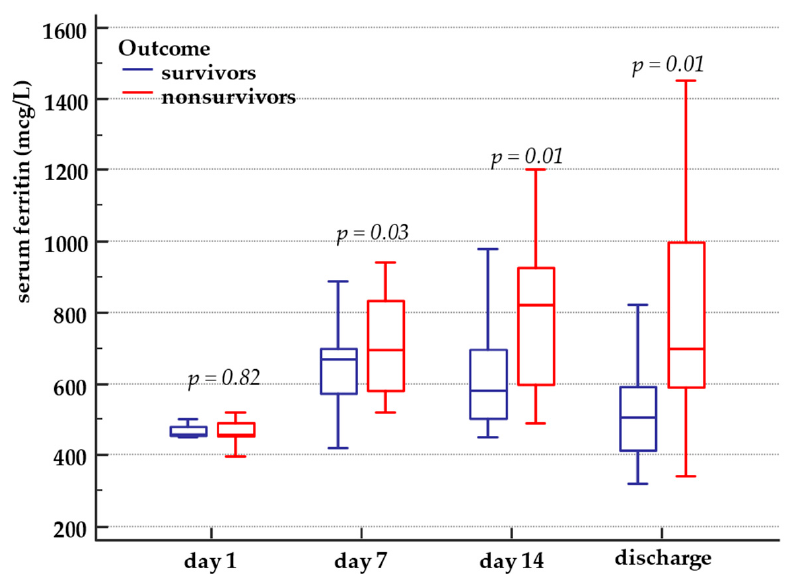
Figure 3. Serum ferritin dynamics in survivors and nonsurvivors. Serum ferritin minimum and maximum value, interquartile range and median value in survivors and nonsurvivors, from ICU day 1 until hospital discharge or in-hospital death. As expected, the SOFA score was significantly higher over time in nonsurvivors than in survivors (Figure 4).